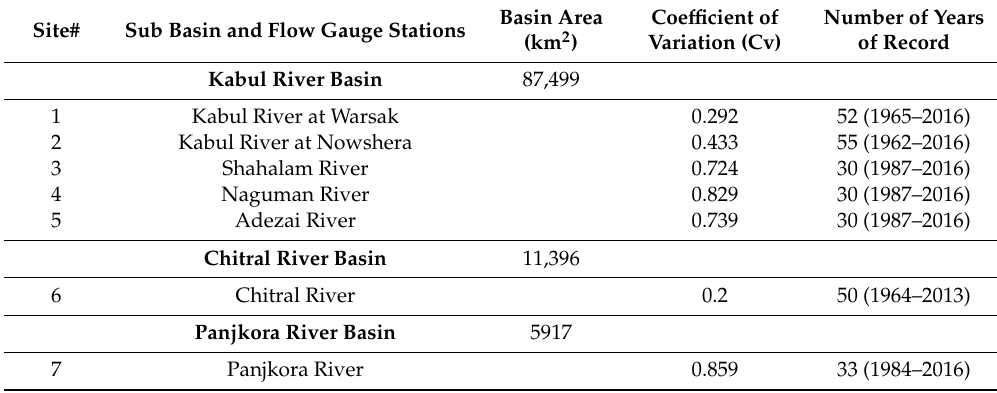
Table 1. Basic information of flow gauges and sub-basins in the KRB,